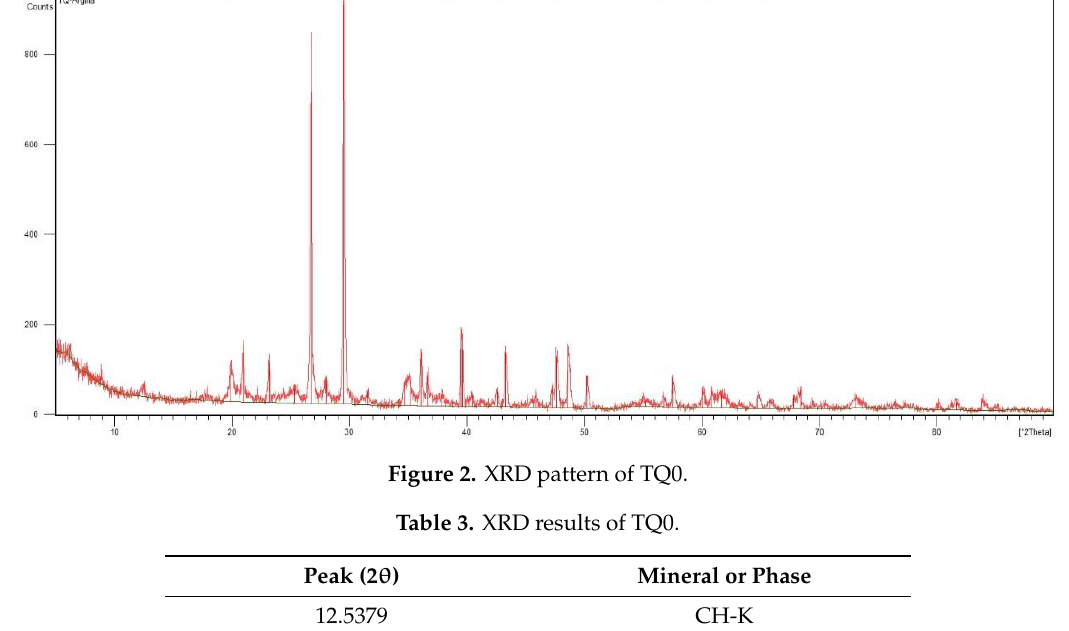
Table 3. XRD results of TQ0.